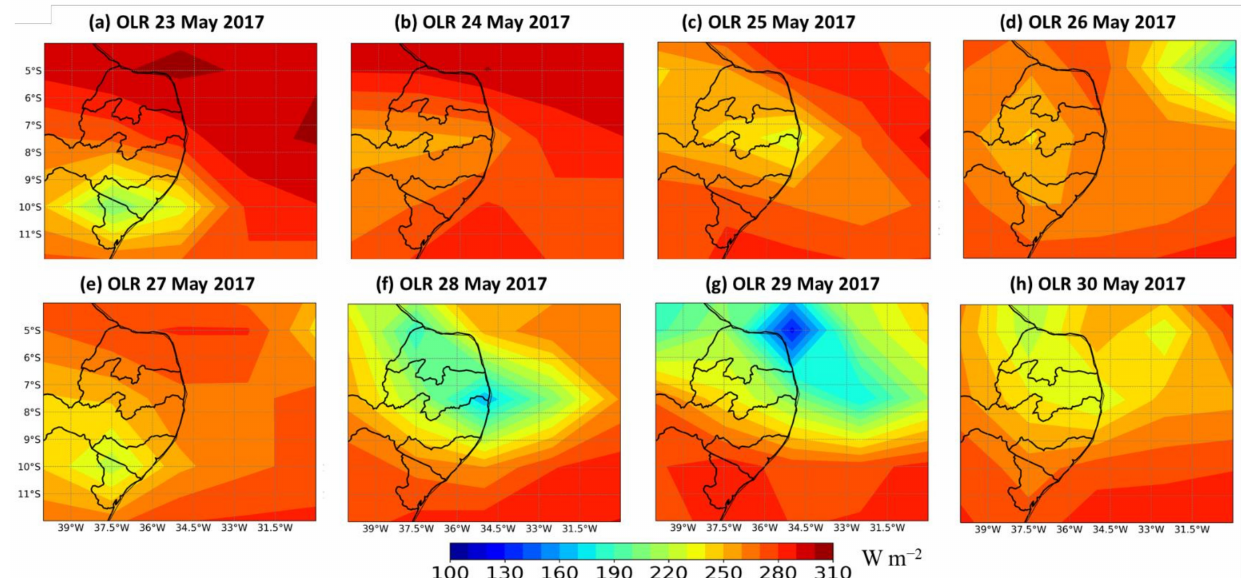
Figure 8. Outgoing Longwave Radiation (OLR) fields (W m − 2 ) from 23 May 2017 to 30 May 2017 at the ECNEB during the action of the rainfall system. The information corresponds to 23 ( a ), 24 ( b ), 25 ( c ), 26 ( d ), 27 ( e ), 28 ( f ), 29 ( g ) and 30 ( h ) May 2017.